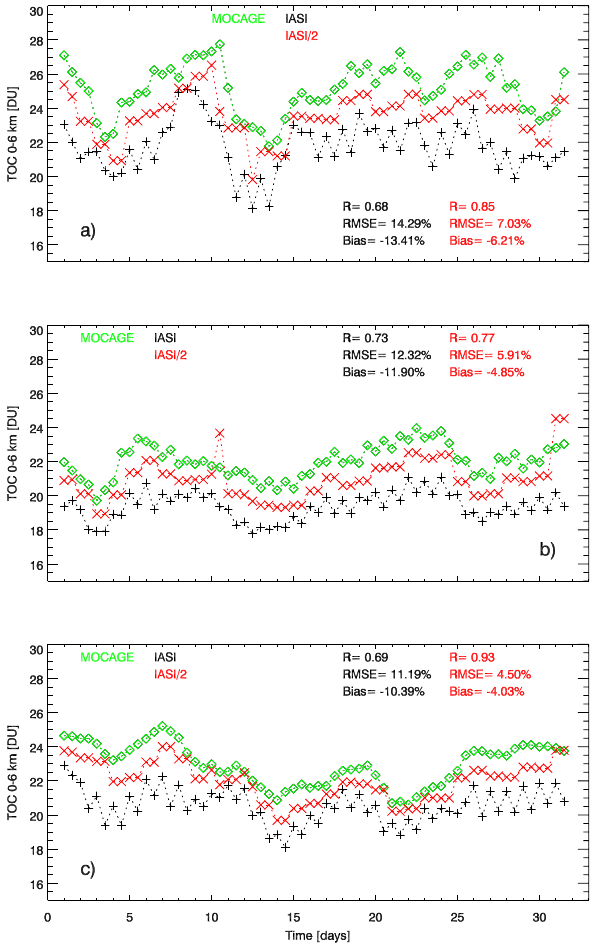
Fig. 10. Time series of MOCAGE pseudo-reality (green), and IASI (black) and IASI/2 pseudo-observations (red) over Po Valley (a) , eastern (b) and western section of the Mediterranean Basin (c) . Mean percent biases, percent RMSEs and Pearson coefficients are also reported for the two instruments.